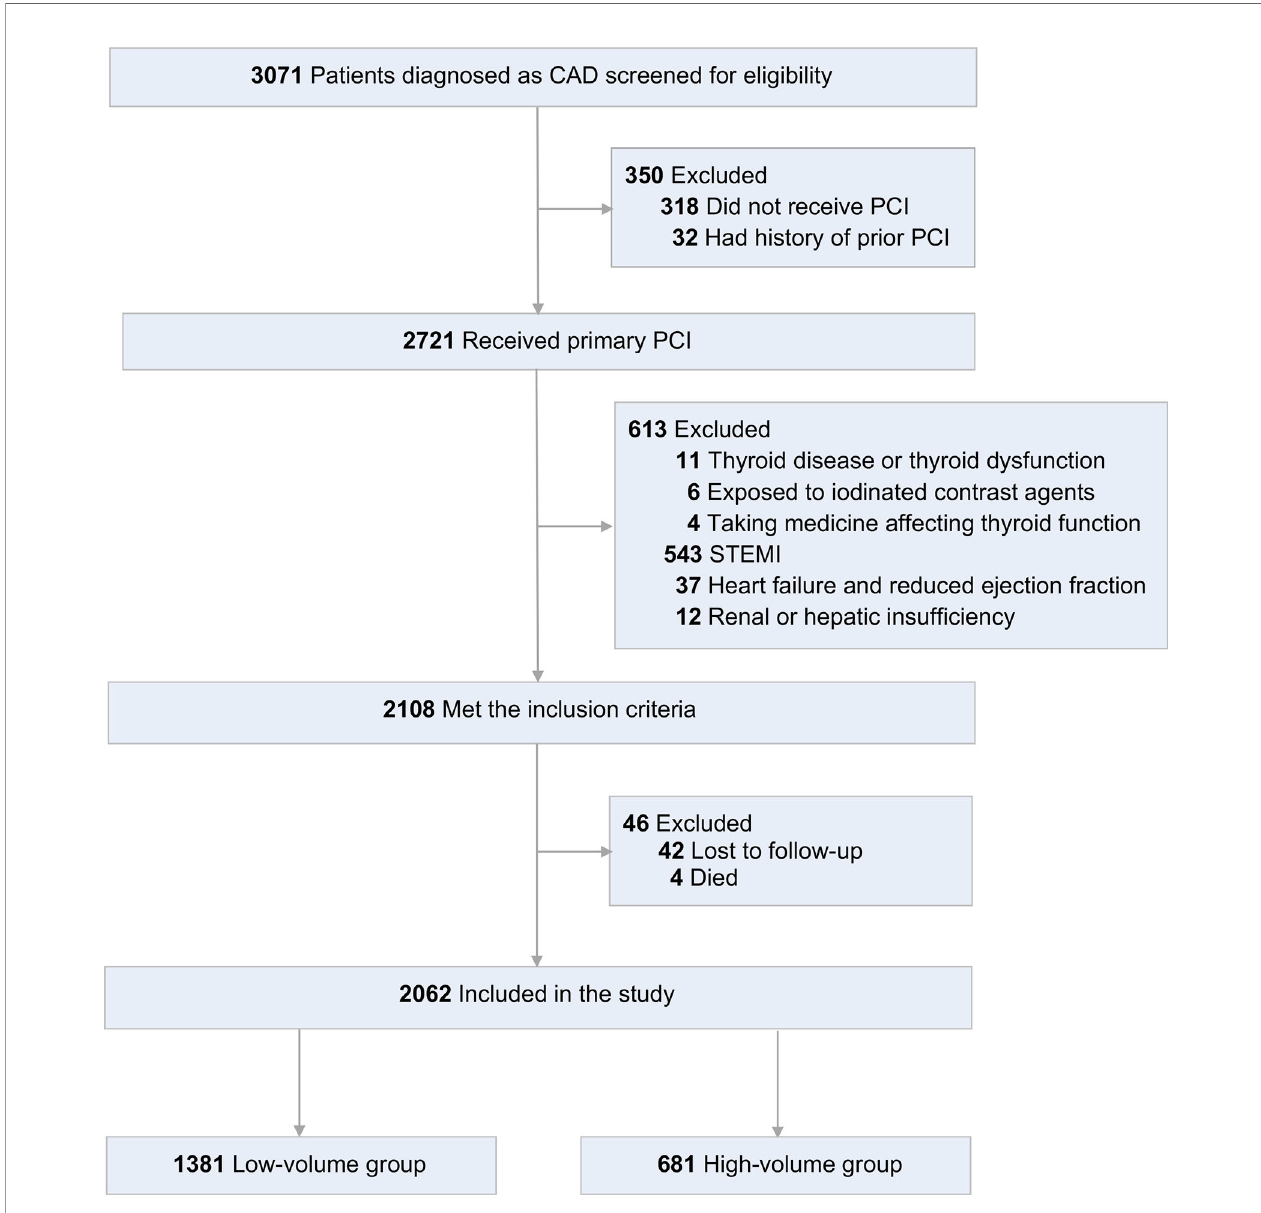
FIGURE 1 | Flow diagram for identifying study population. CAD, coronary artery disease; PCI, percutaneous coronary intervention; STEMI, ST-segment elevation myocardial